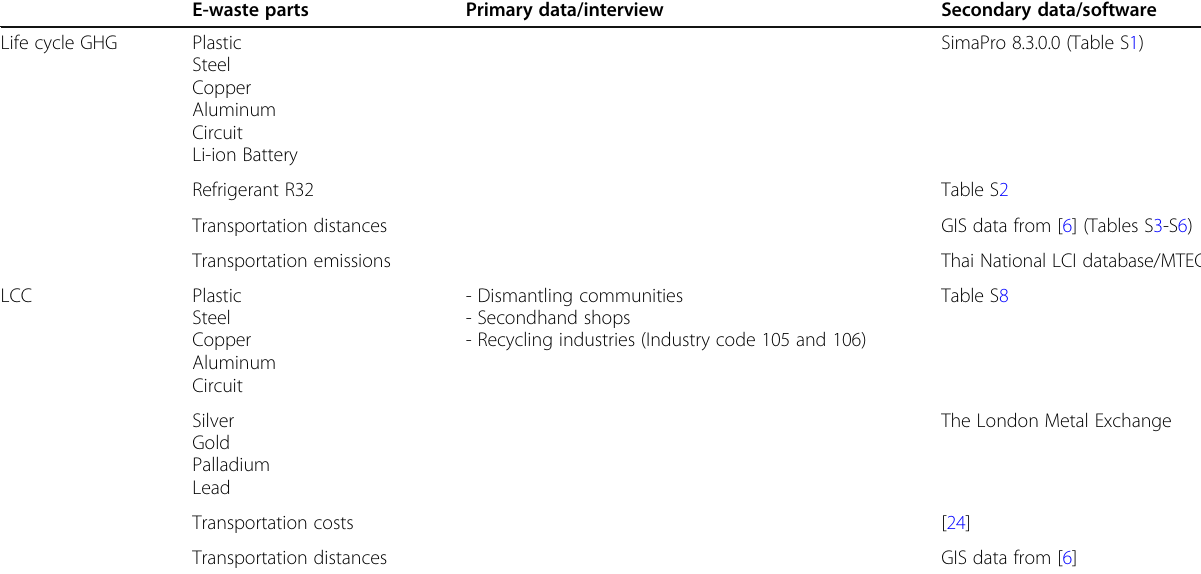
Table 1 Data sources for life cycle GHG and